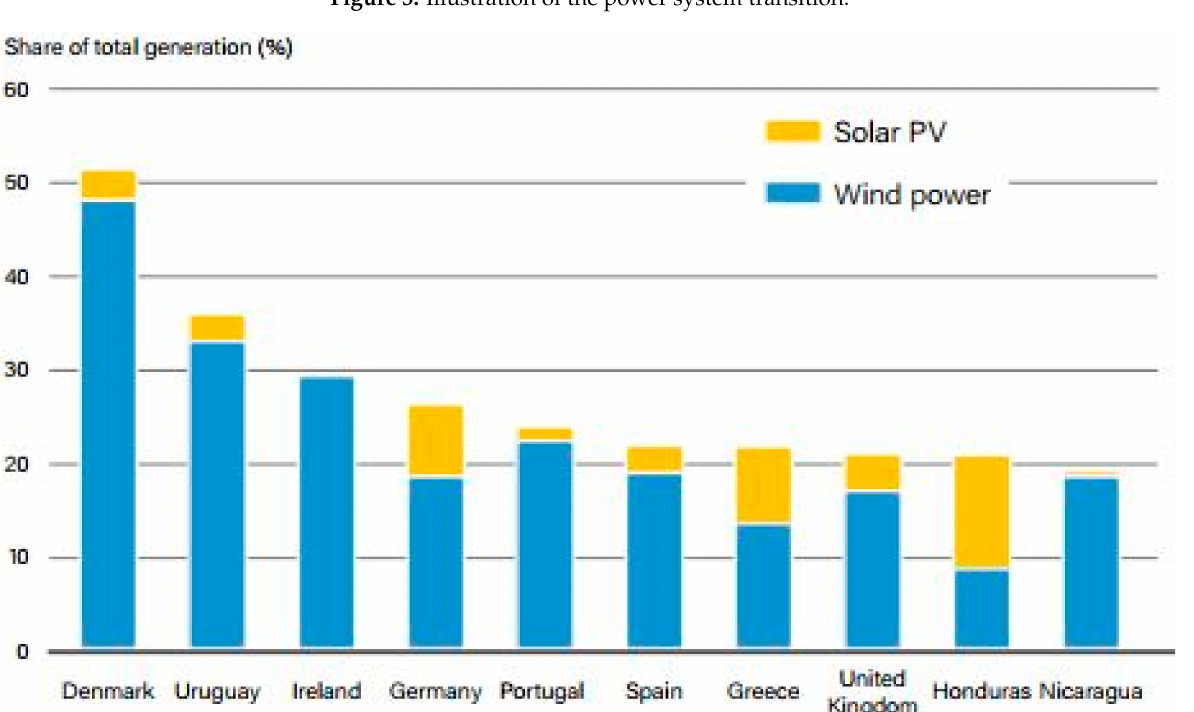
Figure 3. Illustration of the power system transition.